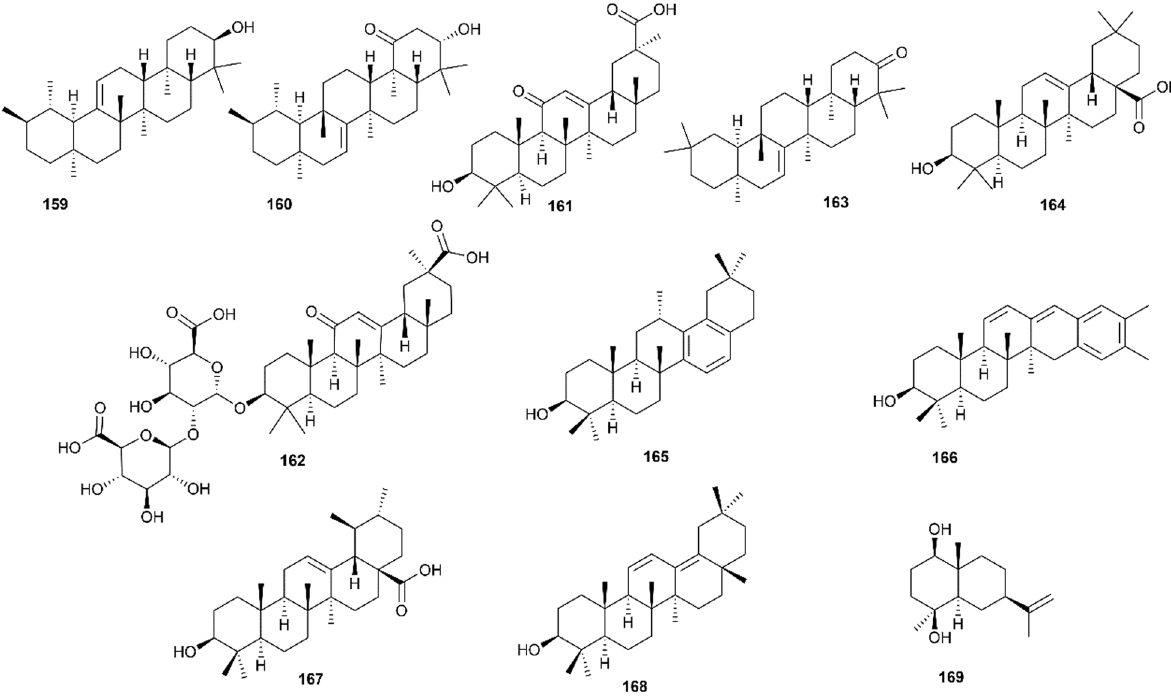
Fig. 6 Other terpenoids isolated from Euodiae Fructus